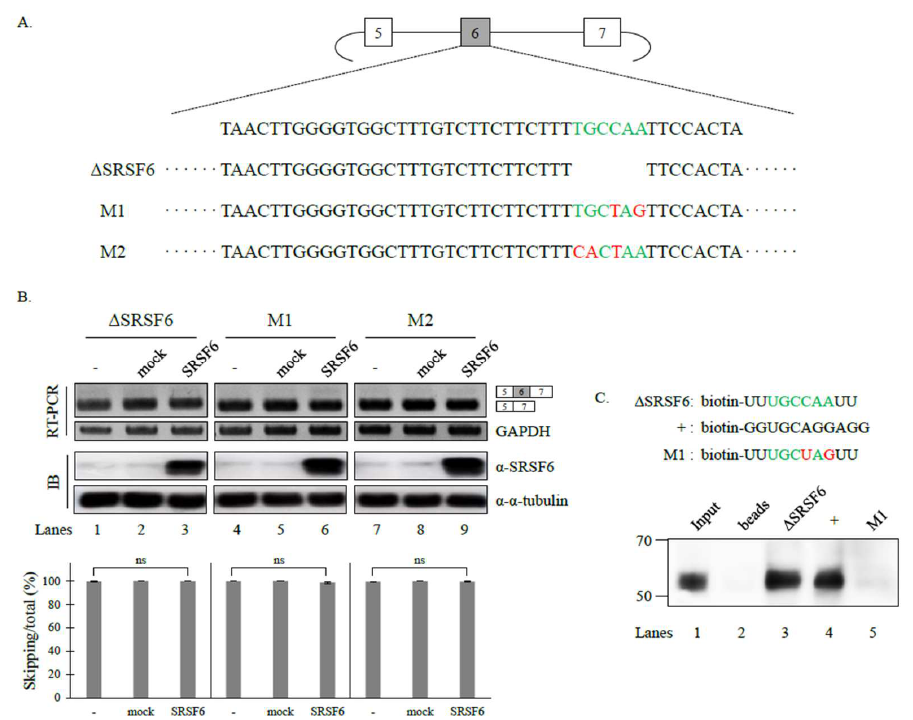
Figure 2. SRSF6 contacts a novel RNA sequence to promote cassette exon inclusion. ( A ) Sequences of wild type, deleted (ΔSRSF6), and substituted mutant (M1 and M2) minigenes are shown. Deleted RNA sequences are indicated in green. Substituted nucleotides are indicated by red. ( B ) (Upper) RT-PCR analysis of mutant minigenes with RNAs from untreated, empty vector-treated, and SRSF6-overexpressed HEK293T cells. (Lower) Statistical analysis graphs of RT-PCR with p values. ( C ) (Upper) Chemically synthesized biotin-labeled ΔSRSF6, M1 and + (positive control) RNA sequences. (Lower) RNA-pulldown and immunoblotting analysis of the biotin-labeled RNAs and anti-SRSF6 antibody. Uncropped figures are shown in Supplementary Figure S3.